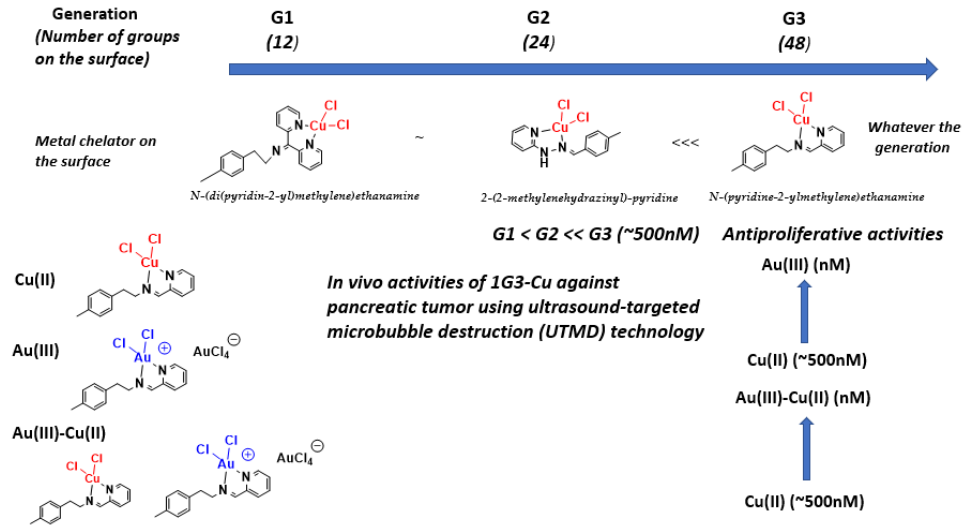
Figure 4. Global view of in vitro and in vivo antiproliferative activies of Cu(II)- and Au(III)-phosphorus dendrimers.